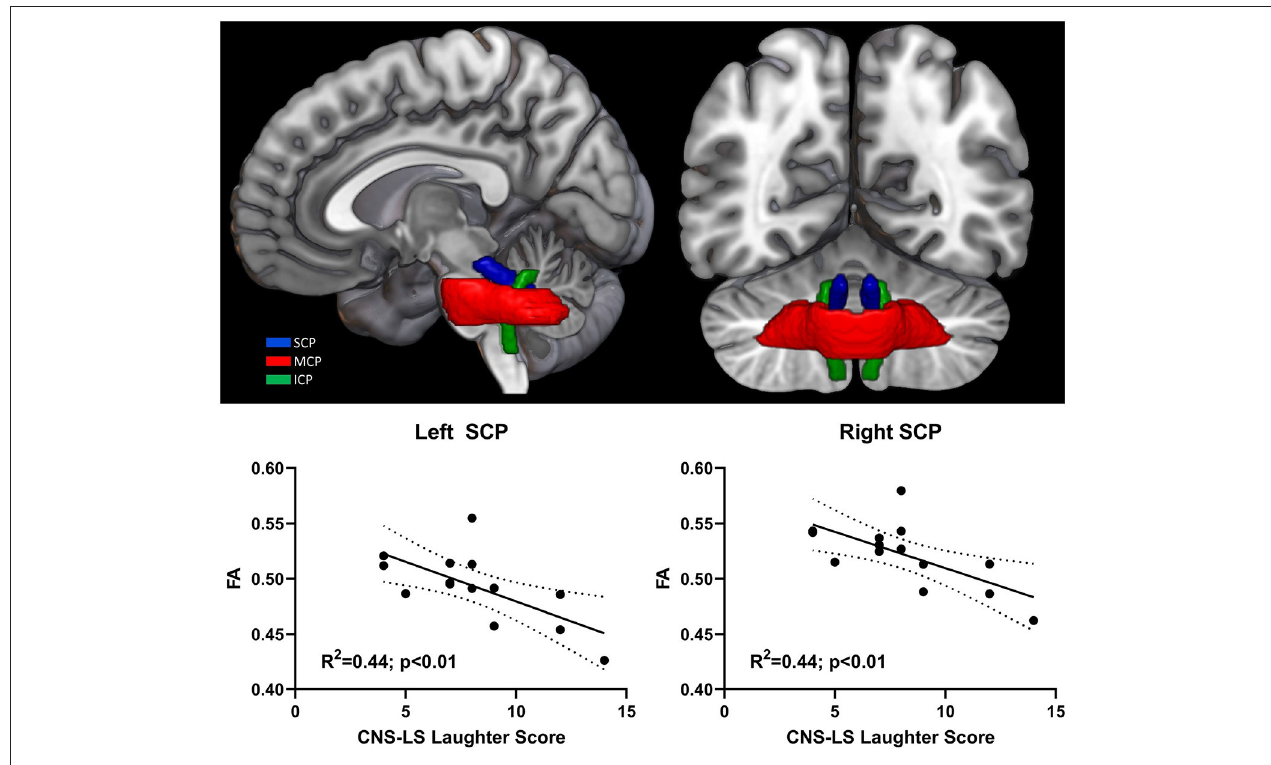
FIGURE 2 | 3D rendering of cerebellar peduncle masks on the MNI152 standard brain. Significant correlation between pathological laughter severity and mean fractional anisotropy of middle cerebellar peduncle in ALS patients. Cerebellar peduncles: superior (SCP); middle (MCP); inferior (ICP).